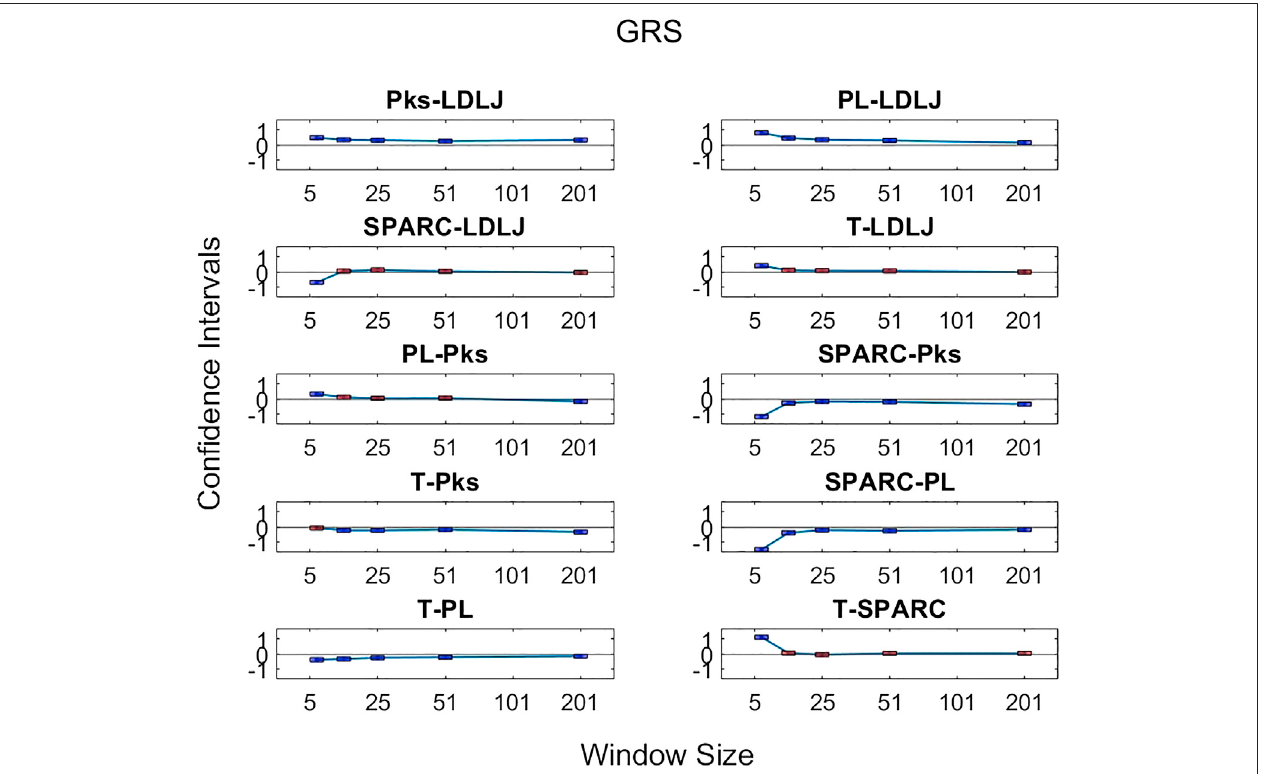
FIGURE 12 | Con fi dence intervals of signi fi cant differences of pairwise comparisons of process metrics with respect to GRS plotted against all tested window spans.Alineisdrawnthroughtheinterceptstobettervisualizethetrendofthecon fi denceintervalsofeachwindowspanincrease.Ifthecon fi denceintervalisabovezero, the minuend is more strongly associated with GRS ; if it passes through zero, the differences are insigni fi cant; and if it is below zero, the subtrahend is more strongly associated with GRS .